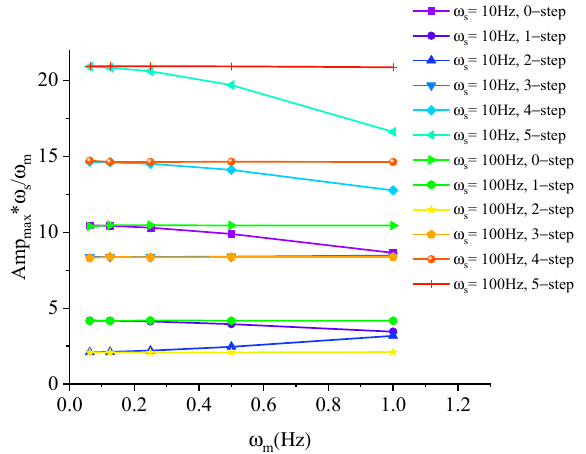
Figure 12. Amplitudes of payload motion with di ff erent frequencies of structure motions.